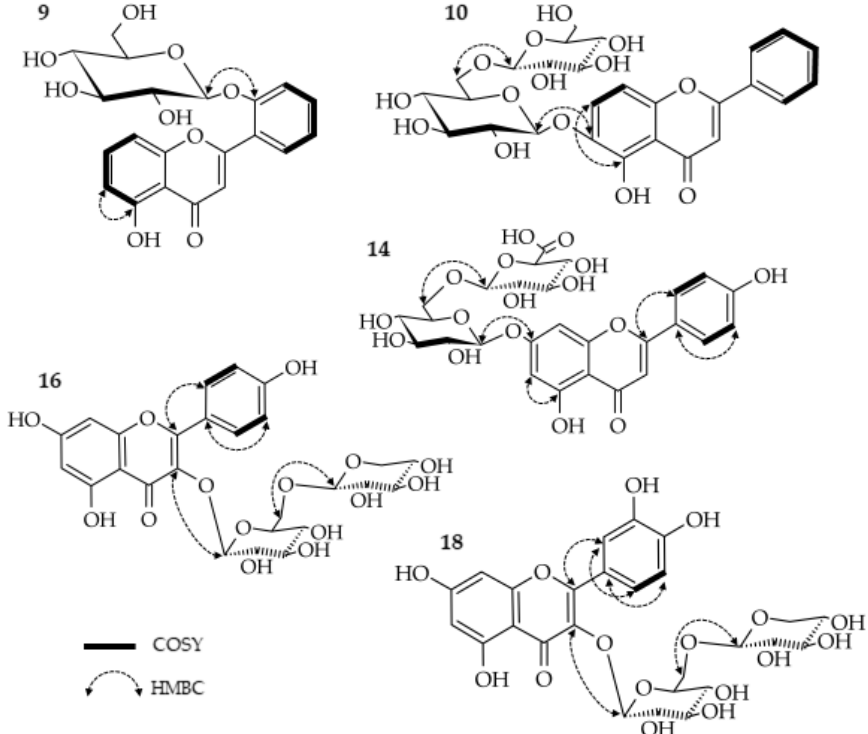
Figure 3. Relevant COSY and HMBC correlations occurring in the spectra of compounds 9 , 10 , 14 , 16 , and 18 isolated from H . palustris .